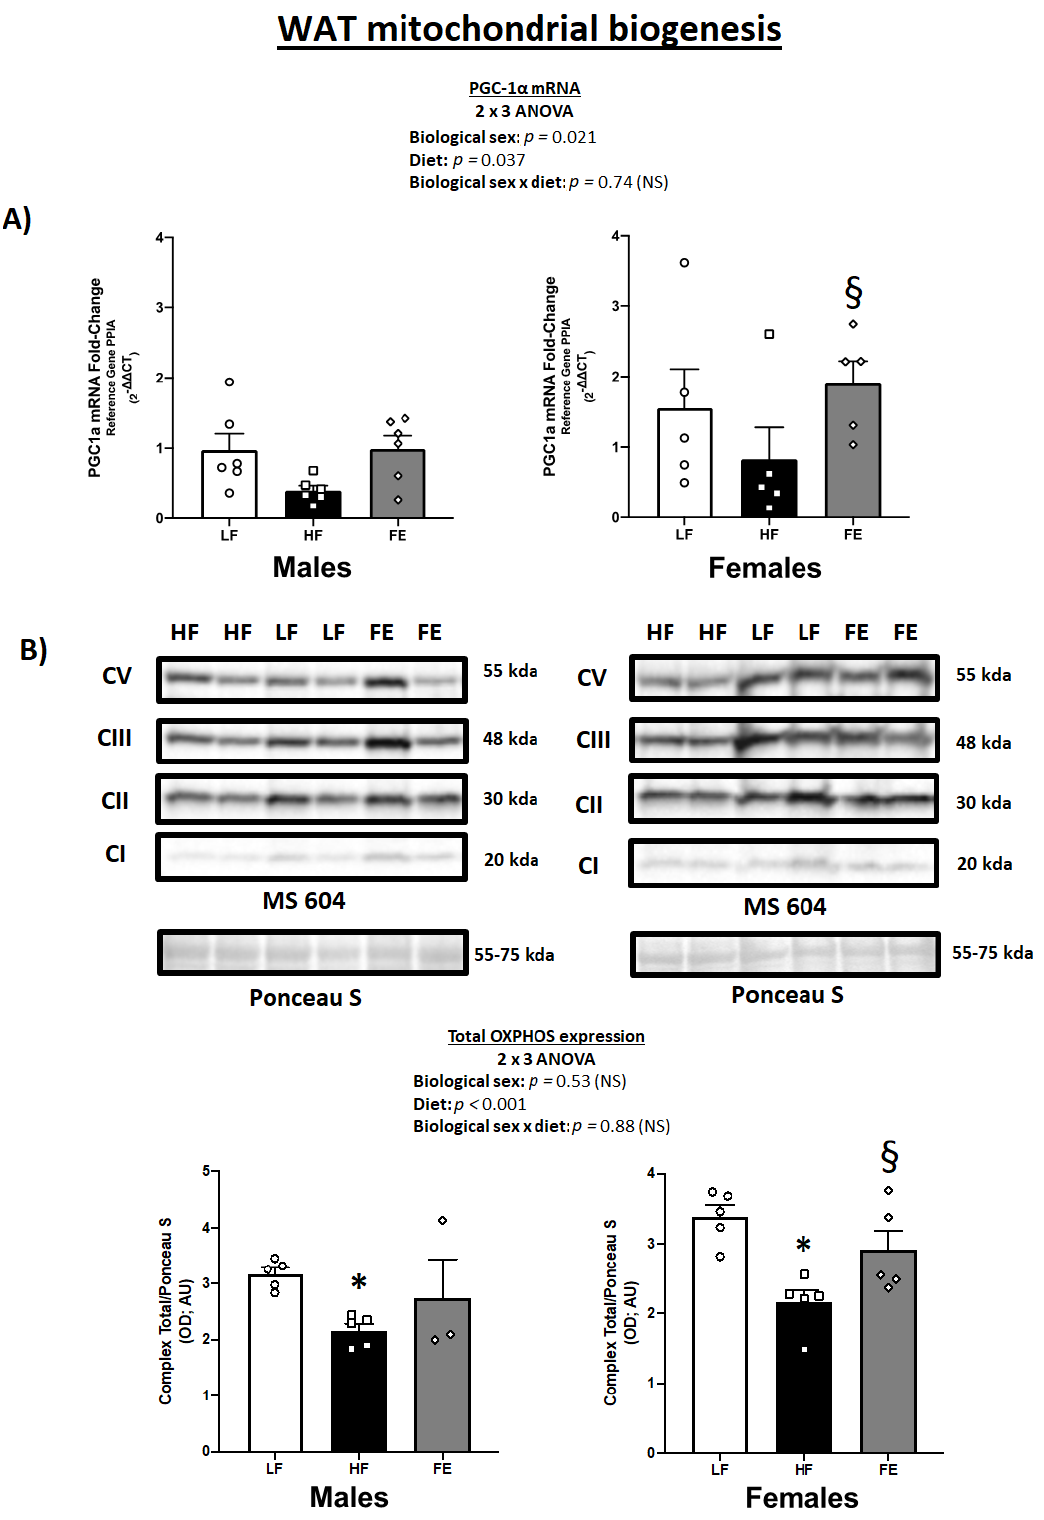
Figure 5. Effects of the ‘Fertility Enhancer’ supplement on PGC-1 α levels and OXPHOS protein expression in perigonadal WAT in Western diet-fed C57BL/6J mice. ( A ) PGC1 α mRNA levels in males and females. ( B ) OXPHOS protein expression in males and females. * Significantly different from LF ( p ≤ 0.05). § Significantly different from HF ( p ≤